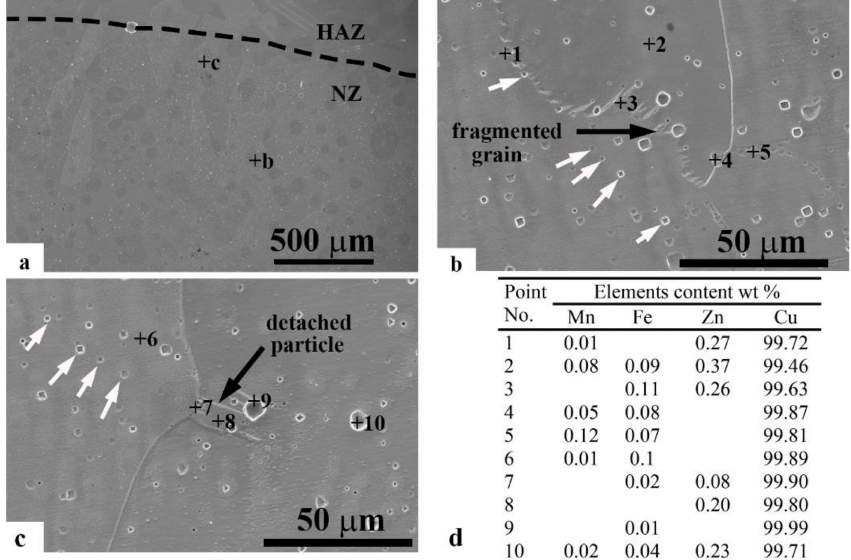
Figure 8. SEM observations of the GTA spot-welded joint assisted with 2 s USV ( a ) low magnification of the nugget surface; ( b ) high magnification for the fragmented grain labeled in a; ( c ) high magnification for the detached particle in the location labeled in a; and ( d ) EDS results of several characteristic regions labeled in b and c.